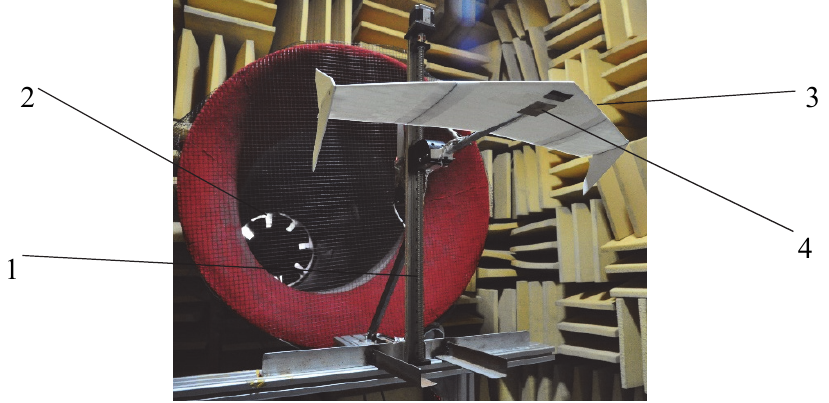
Figure 7. Wind tunnel experiment system. (1) Aircraft support; (2) fan; (3) test UAV sample; (4) six-component strain balance.